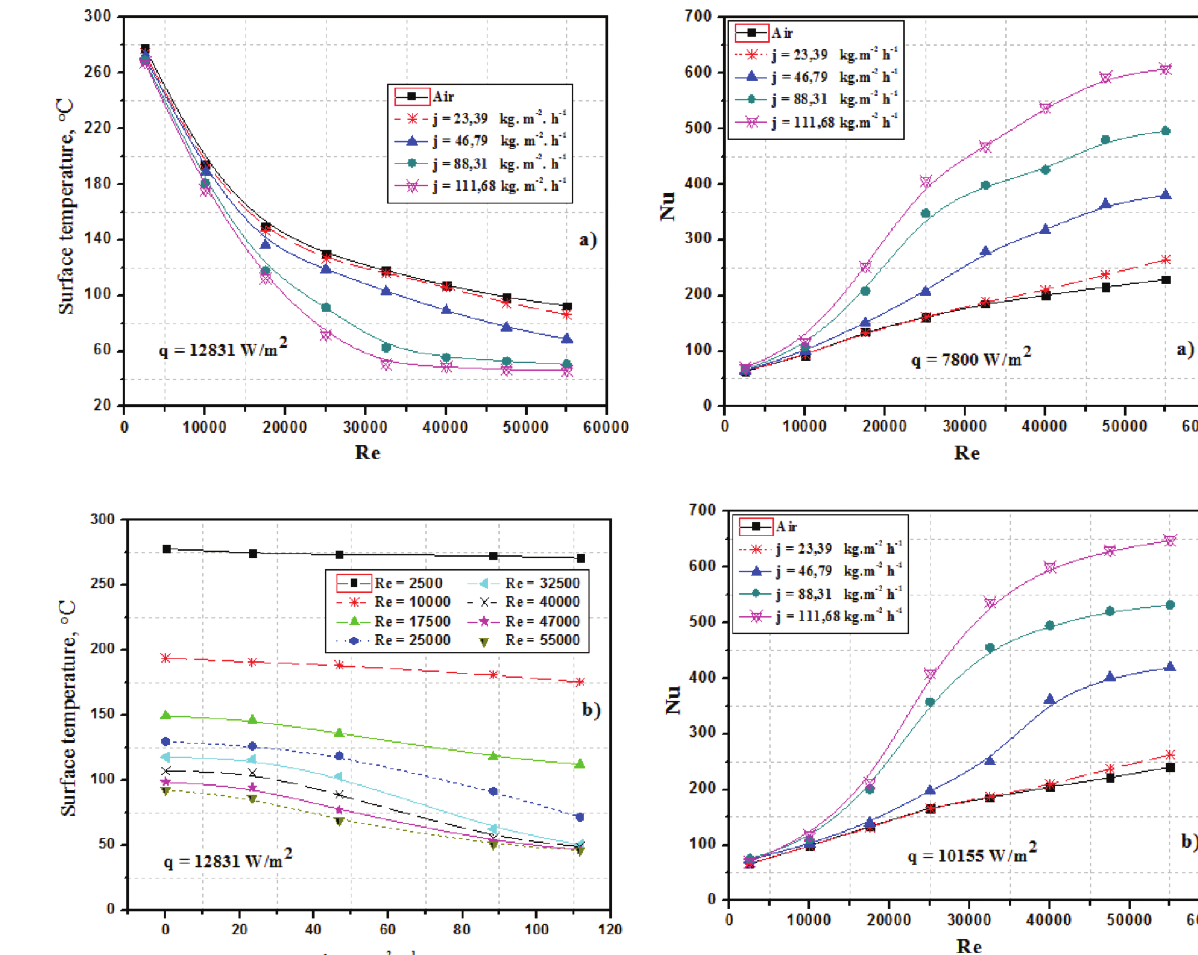
Figure 4. Dependence of average Nusselt number on the Reyn - olds number for heat fluxes equal to 7800 W/m 2 (а) and10155 W/m 2 (б) for different values of water flow density in the